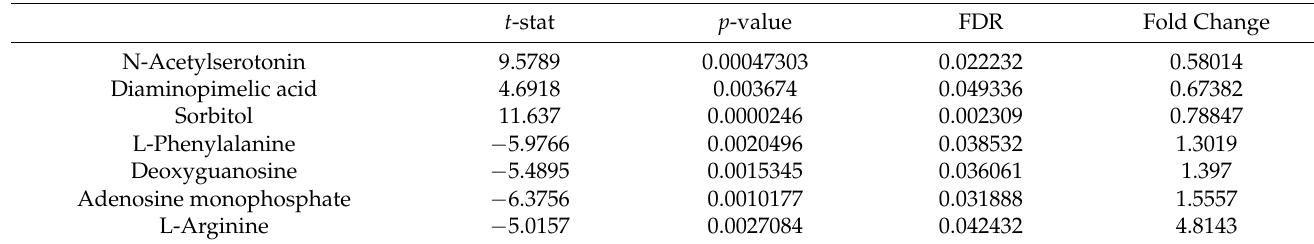
Table 3. Statistically significant metabolites in U373 cells treated with paclitaxel 4.2 nM and/or etoposide 10 µ g/mL.